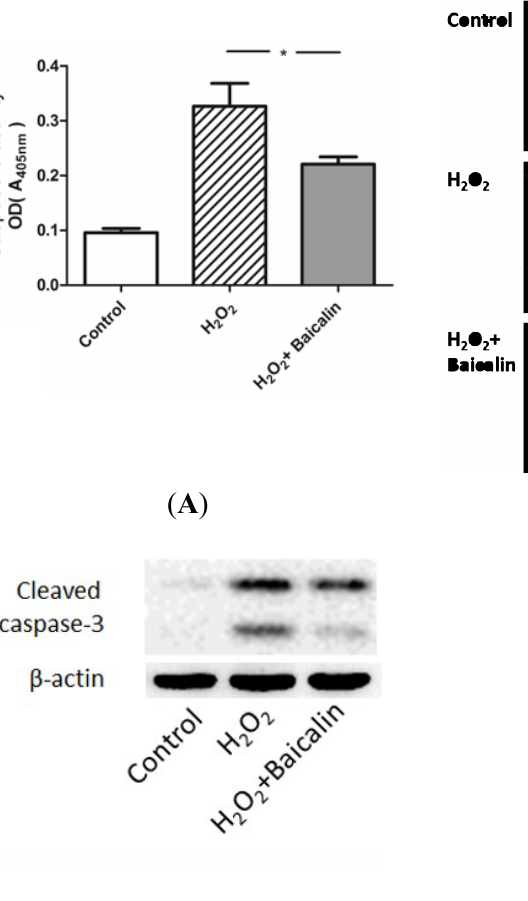
Figure 3. Effects of Baicalin on H